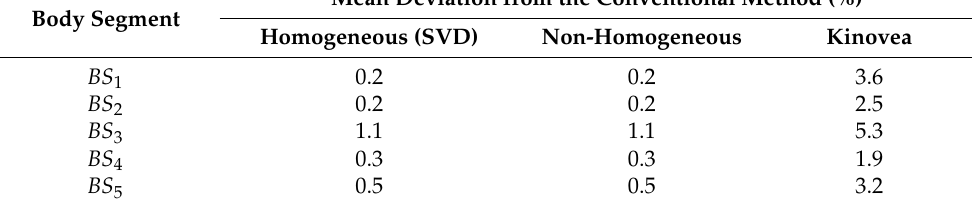
Table 6. Comparison of the deviation between MVS results and MAM’s results for a sample of 12